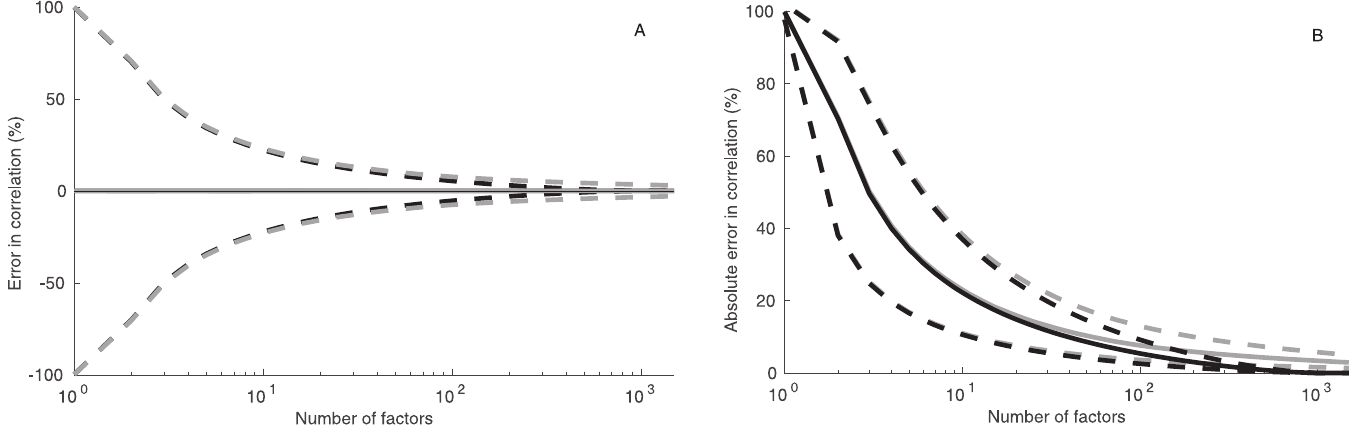
Fig 7. Reproduction of correlation coefficient in randomly-generated data. Error in correlation coefficient reproduction (left panel) of the random data using the random factor model (dashed gray curve) and PCA (black solid curve). Curves are shown as functions of the number of factors. Differences are in percentage points. The right panel shows absolute error in correlation reproduction of the random data using the random factor model (dashed gray curve) and PCA (black solid curve).